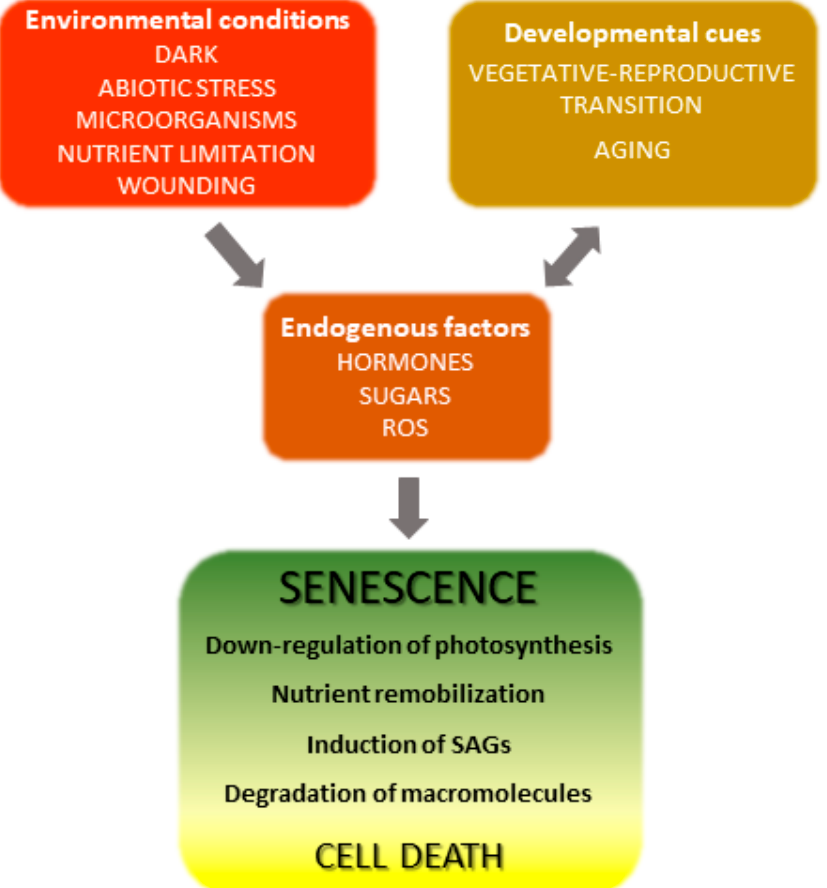
Figure 1. Overview of leaf senescence. The final stages of leaf development are basically determined by plant age and transition into the reproductive stage, but are also modulated by endogenous and exogenous cues which integrate into the developmental program. Environmental conditions affecting senescence progression include biotic and abiotic stresses and nutritional status, whereas hormones represent the most relevant endogenous factors. Many environmental stresses increase propagation of reactive oxygen species (ROS) in leaf tissue, which act as signaling molecules. SAGs, senescence-associated genes.